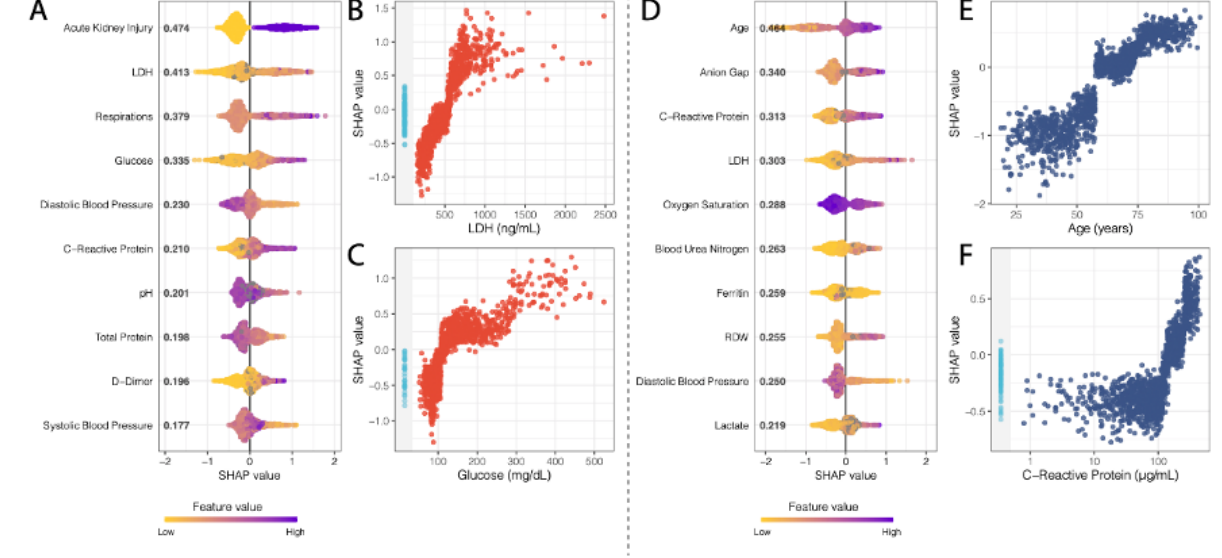
Figure 4. SHAP summary plots for critical event (A) and mortality (D) at 7 days showing the SHAP values for the 10 most important features for the respective XGBoost models. Features in the summary plots (y-axis) are organized by their mean absolute SHAP values (x-axis), which represent the importance of the features in driving the prediction of the classifiers for patients. (B) and (C) Dependency plots demonstrating how different values can affect the SHAP score and ultimately impact classifier decisions for LDH and glucose, respectively, for critical event prediction. (E) and (F) Dependency plots for age and C-reactive protein levels. Patients with missing values for a feature in the dependency plot are clustered in the shaded area to the